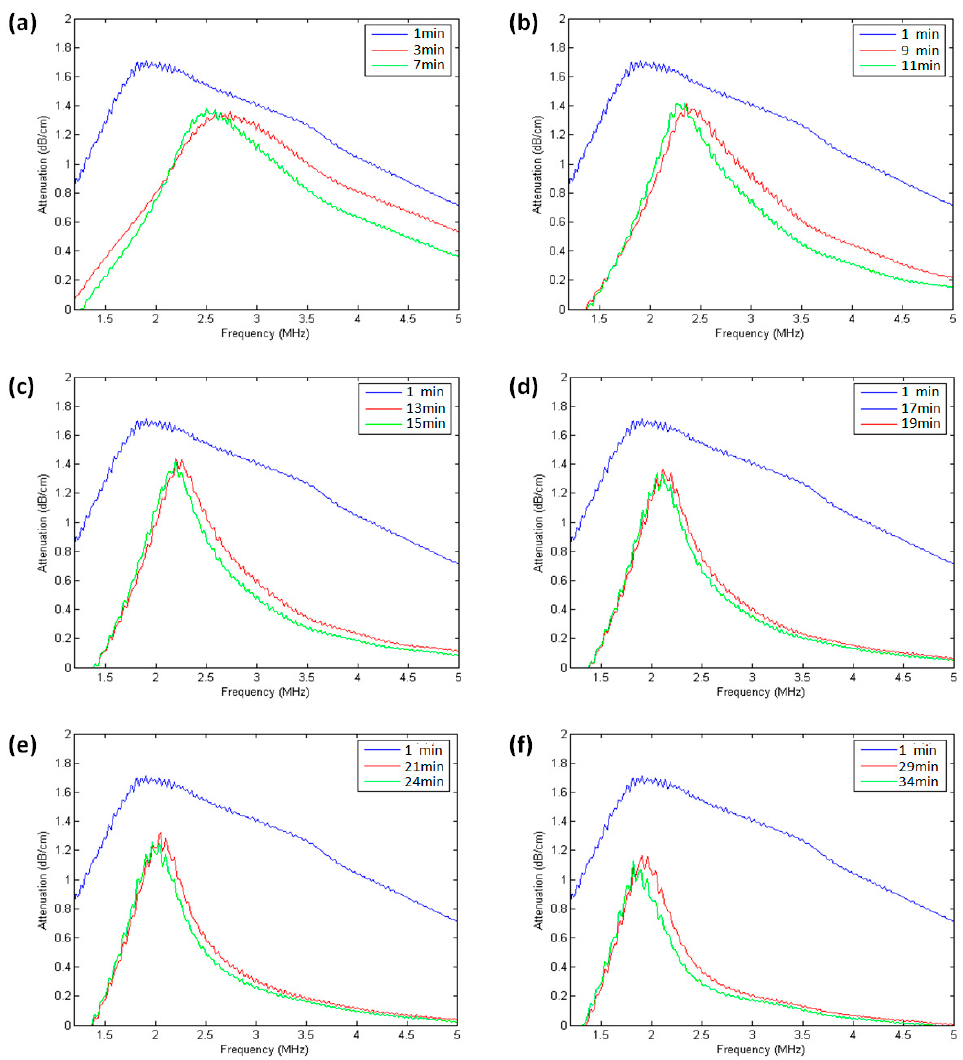
Figure 4. Acoustic attenuation spectra at different time after injecting SonoVue microbubbles suspensions. ( a ) 1, 3, and 7 min, ( b ) 1, 9, and 11 min, ( c ) 1, 13, and 15 min, ( d ) 1, 17, and 19 min, ( e ) 1, 21, and 24 min, and ( f ) 1, 29, and 34 min after injection.